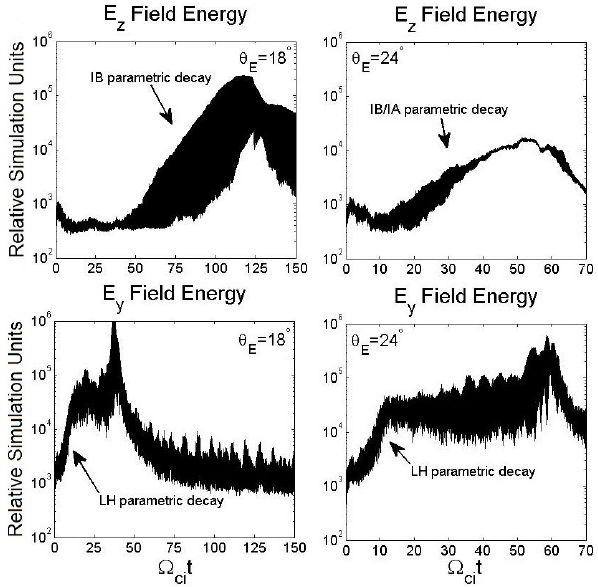
Fig. 3. Simulated time evolution of electrostatic field energy par- allel (z-field) and perpendicular (y-field) to the background mag- netic field shows development of lower hybrid (LH) decay instabil- ity (y-field) for both cases, IB decay instability (z-field) for the case θ E = 18 ◦ and neutralized IB/oblique IA decay instabilities (z-field) for the case θ E = 24 ◦